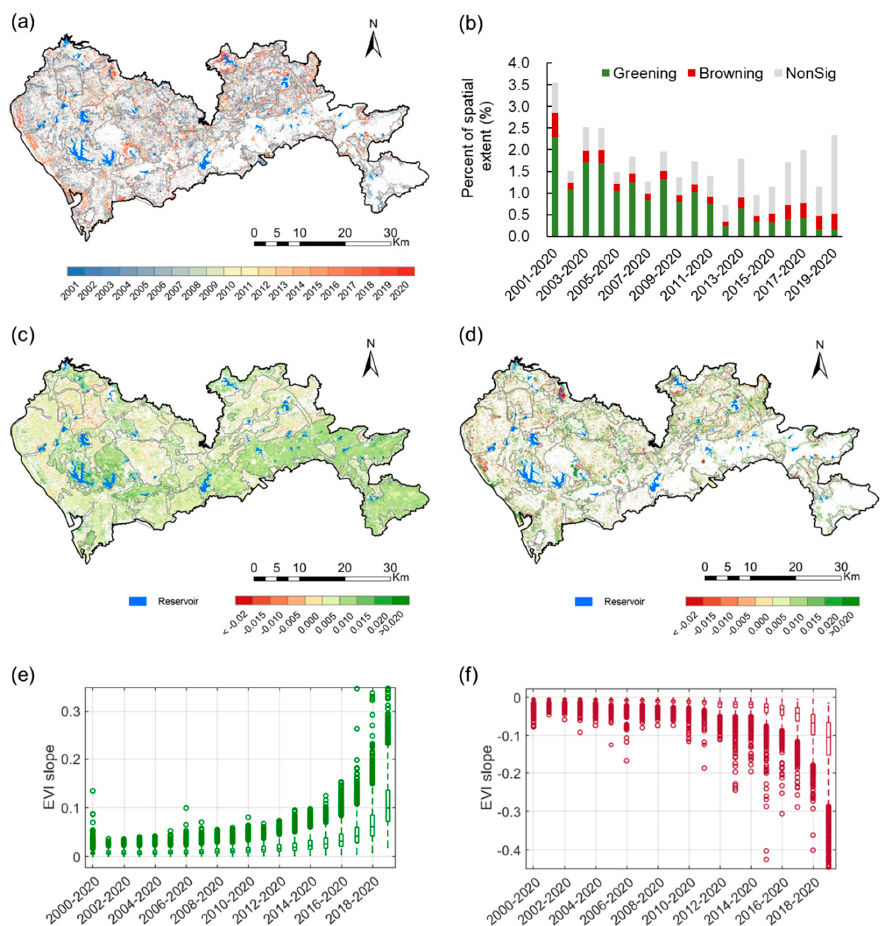
Figure 6. Spatial and temporal patterns of vegetation change in the recent period. ( a ) latest change year, (b ) trends in the latest change period, ( c ) EVI slope with persistent change in 2000–2020, ( d ) EVI slope in the latest changing period, ( e ) and ( f ) data distribution of the EVI slopes in recent change period for greening and browning.